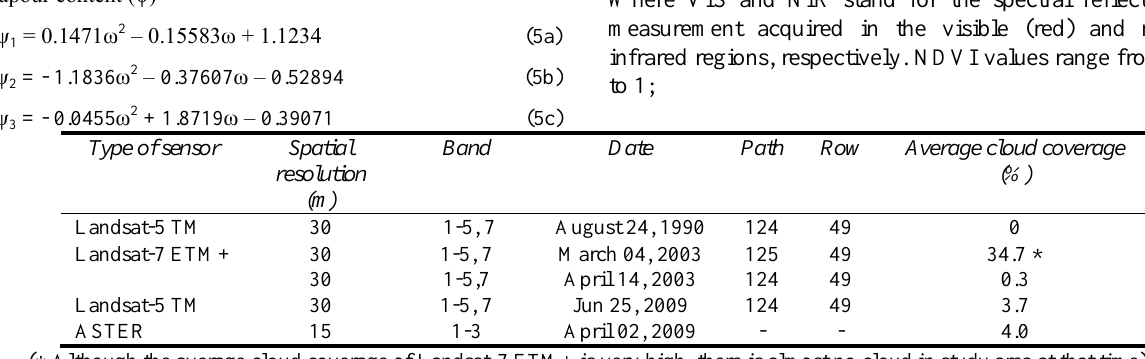
Table 1. Characteristics of satellite data used in study area